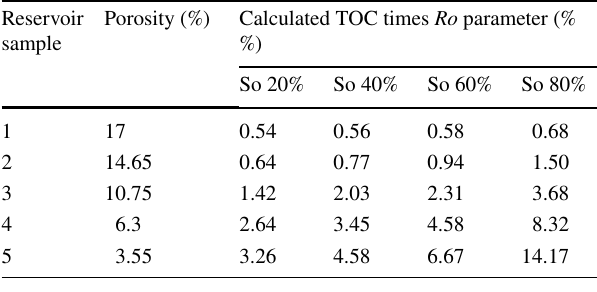
Table 3 Parameters of calculated TOC times Ro for different porosity and oil saturation values Reservoir sample